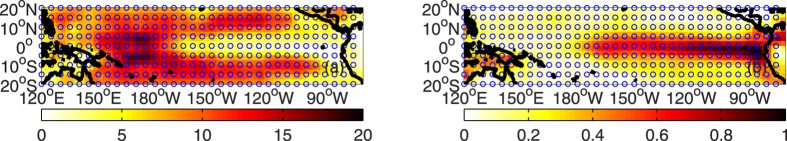
Spatial distributions of node degrees Ki and node vulnerabilities Fi.(a) shows the spatial distribution of Ki in the idealized network (see Fig. 4). A node with red color means it has more connections (higher K) than a node with yellow color. Therefore, this figure corresponds to the Most connected Attack (MA), which removes nodes according to the decreasing sequence of node degree Ki. (b) shows the spatial distribution of Fi. A node with red color means it is more vulnerable (higher F) than a node with yellow color. Therefore, this figure corresponds to the Localized Attack (LA), which removes nodes according to the decreasing sequence of node vulnerability Fi. These two figures are generated by using Matlab (version R2012a, http://www.mathworks.com/pl_homepage).